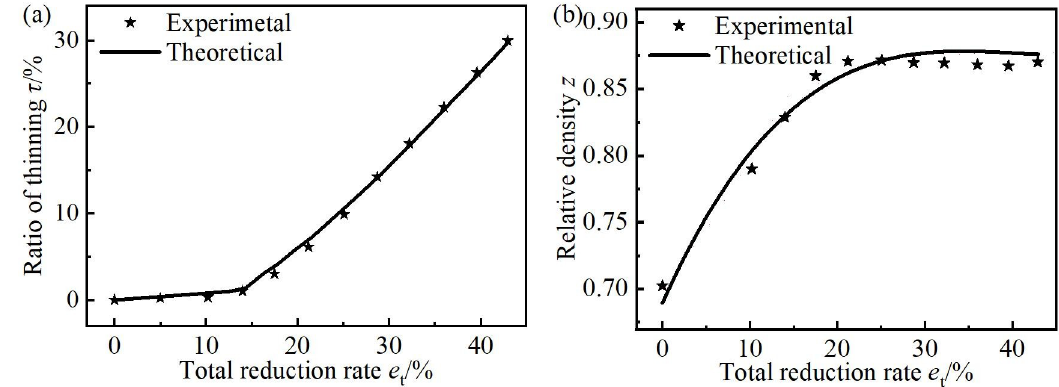
Fig 10. Comparison of the analytical and experimental results of the CORFT. (a) Ratio of thinning, and (b) relative density.